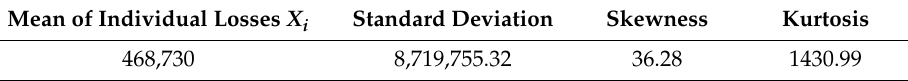
Table 3. Descriptive statistics of Mean of individual losses X i (in